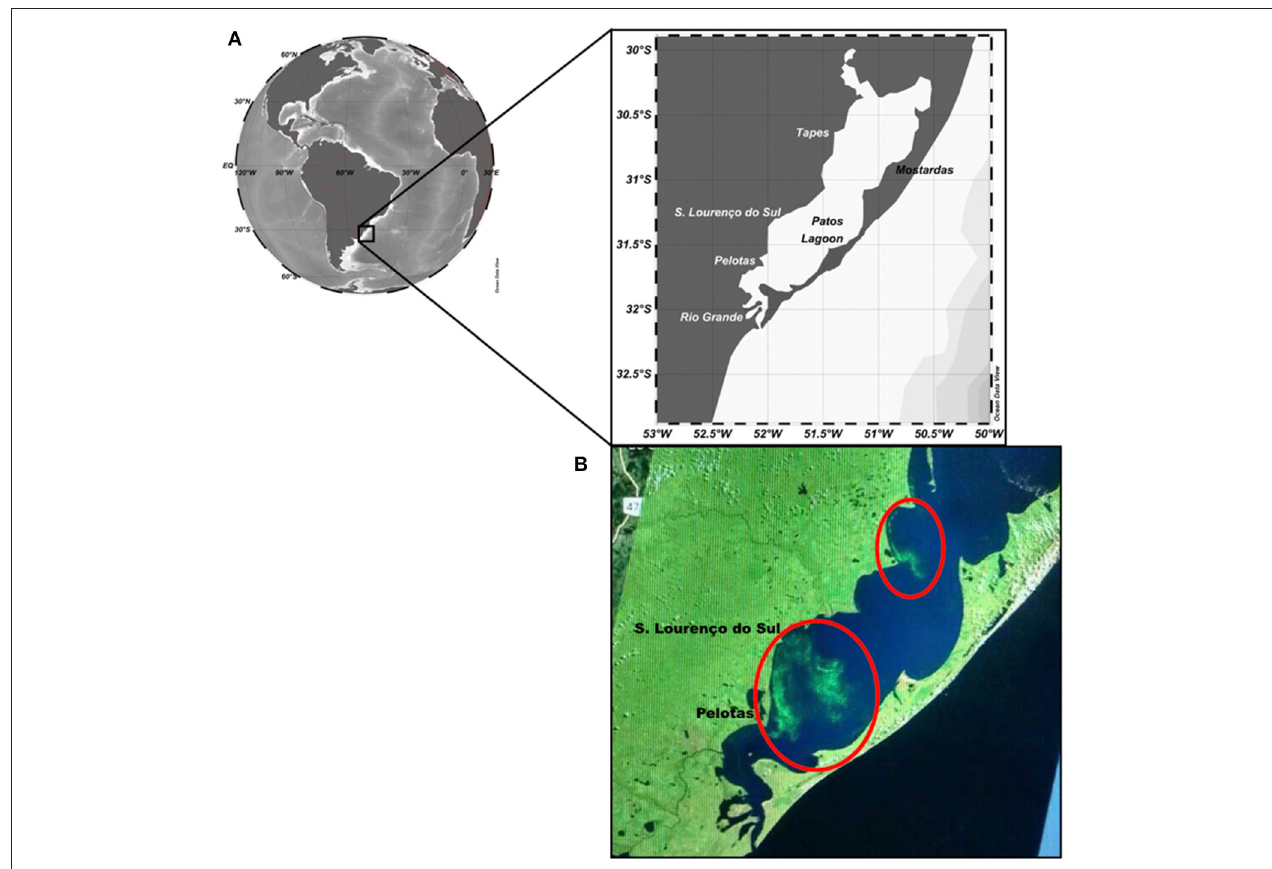
FIGURE 1 | Map of the study area showing (A) cities at the west margin of the Patos Lagoon system, where patches (two red ellipses) of Microcystis spp. have been notified; (B) patches of Microcystis spp. (inside of the red circle) seen on 02 February 2017, retrieved from Landsat-8 Enhanced Thematic Map plus (ETM + ; https://